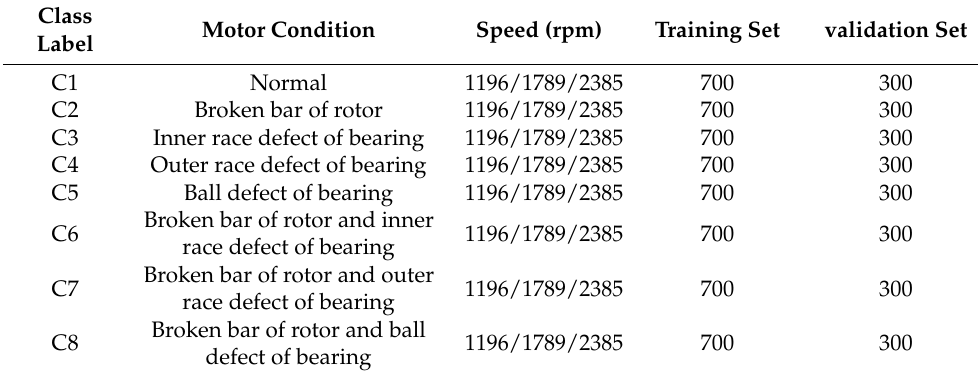
Figure 9. Vibration and current signals from the motor under 8 working conditions. Table 1. Details of the experimental dataset. Table 1. Details of the experimental